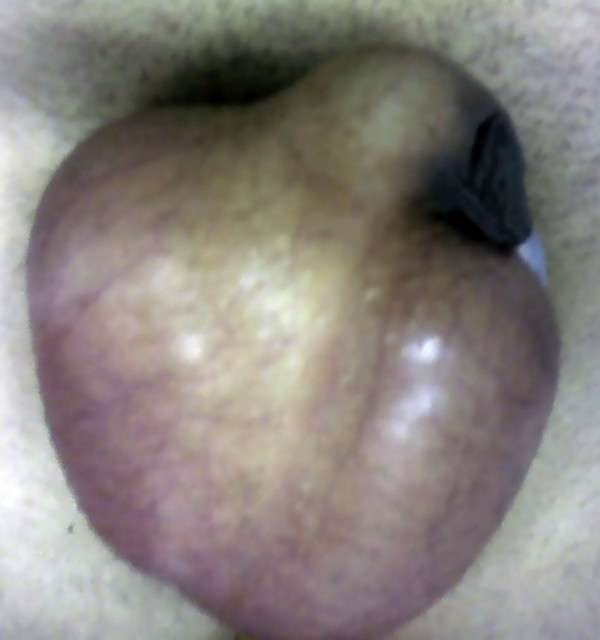
Oedematous scrotum.